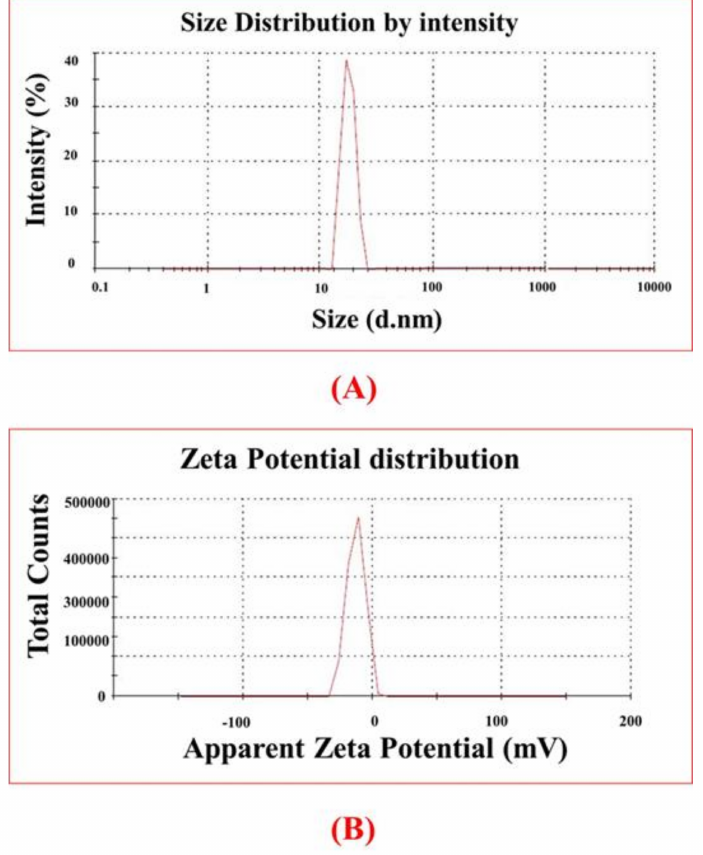
Figure 2. D.L.S spectral studies; ( A ) Zeta size; ( B ) Zeta potential distribution. Furthermore, the UV vis-absorption spectrum was obtained utilizing a spectrometer (UV–Vis spectrophotometer (Munich, Germany), and the UV absorption peak was noted at 332 nm (Figure 3A). In the FTIR spectrum of E. angustifolia mediated NiONPs, peaks present at 3278.11 cm − 1 , 1614.13 cm − 1 , 1417.46 cm − 1 , 995.99 cm − 1 signify O-H, C=C, -C=O and C-H stretching. However, peaks at 545.45 and 681.77 cm − 1 correspond to NiO bond vibrations from NiONPs. The results of the FTIR spectrum are illustrated in Figure 3B. Further, the XRD data revealed different diffraction peaks with 2 theta values of